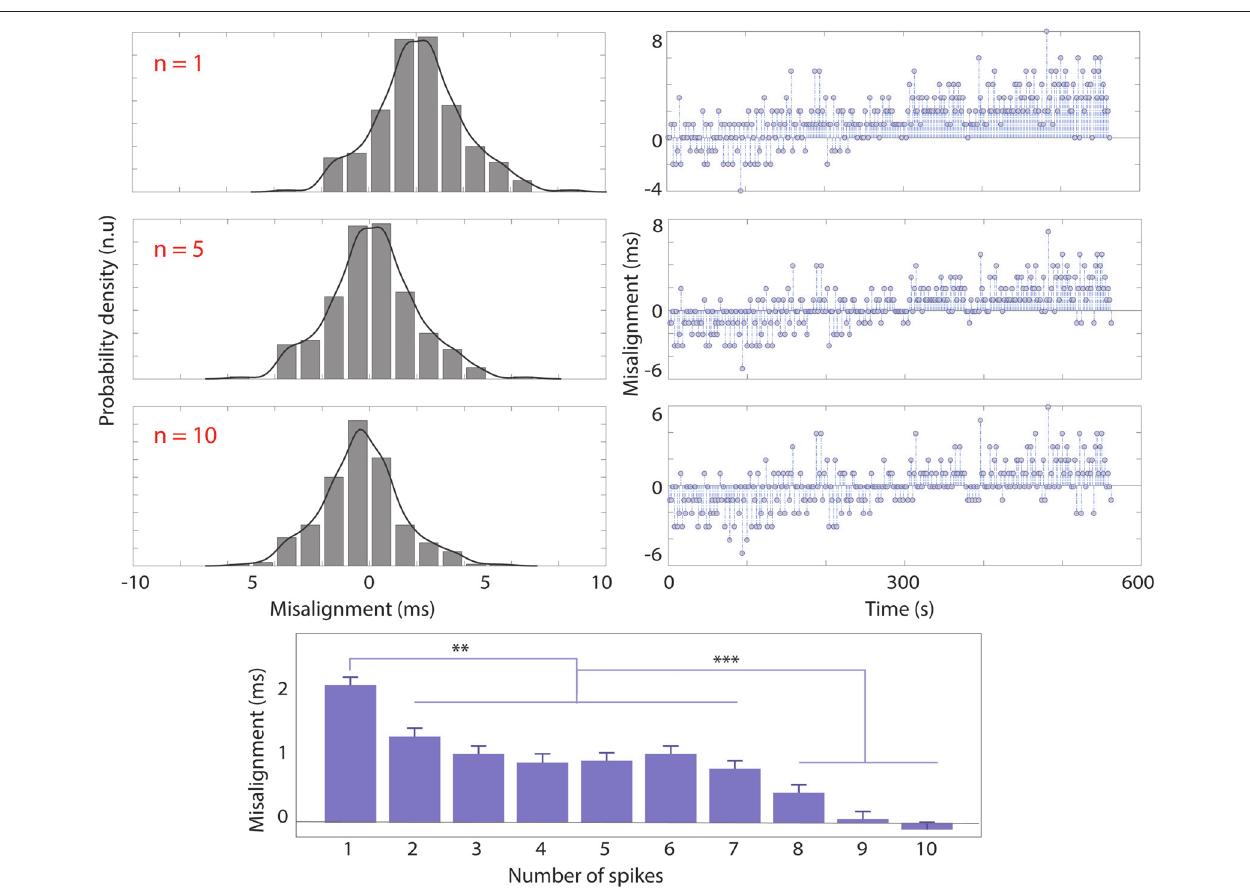
FIGURE 4 | Probability density histogram and kernel-fitted probability density function (left) and trend (right) of spike misalignment throughout the recording (10 min) respectively using n = 1 (top row), n = 5 (middle row), n = 10 spikes before and after the recording session for synchronization. The bottom panel shows the average misalignment (ms) and standard deviation as a function of the number of spikes used for synchronization (n). Significant differences are marked with ∗∗ p < 0.01 and ∗∗∗ p <